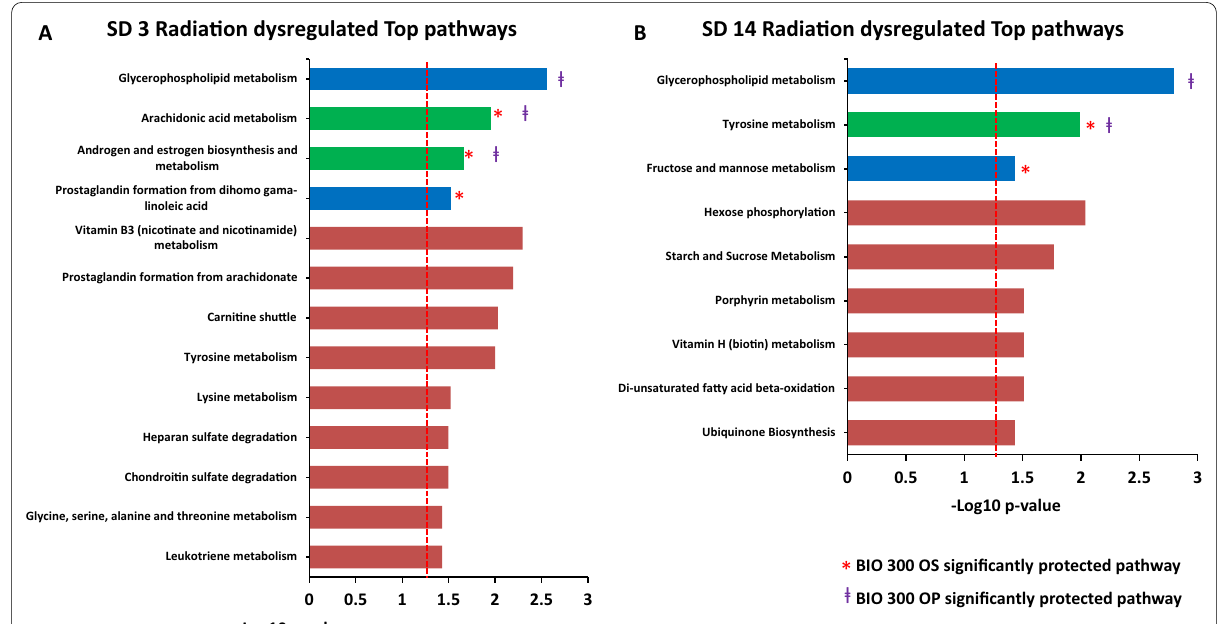
Fig. 6 Pathway analysis showing significantly dysregulated pathway perturbations at SD3 (Panel A ) and SD14 (Panel B ). The bars in blue denote pathways corrected by BIO 300 OP, while bars in green are corrected by BIO 300 OS and